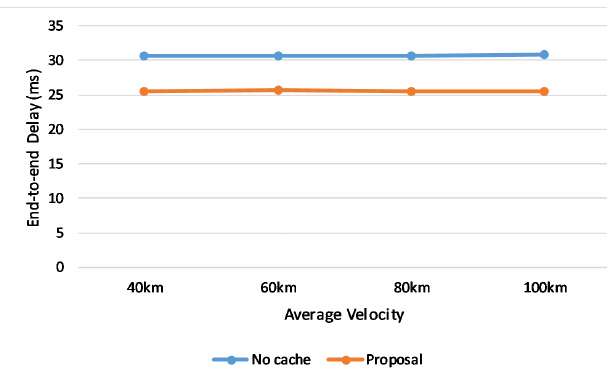
Figure 10. Comparison of end-to-end delay.